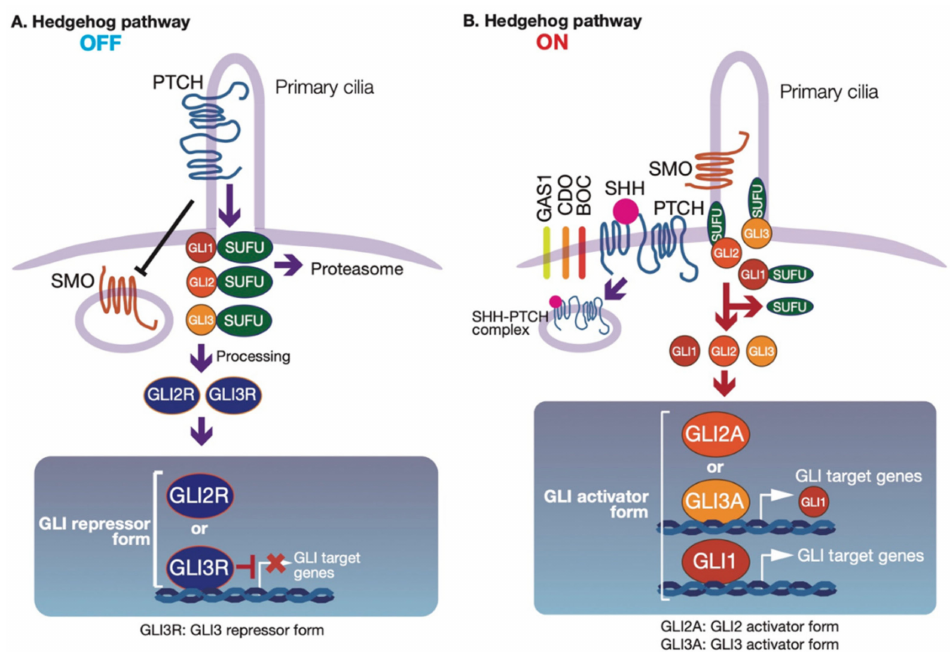
Figure 1. Hedgehog (HH) signaling pathway. ( A ) In the absence of HH ligands (the OFF state), Patched (PTCH) inhibits Smoothened (SMO) from primary cilia, and Suppressor of Fused (SUFU) binds to glioma-associated oncogenes (GLIs) and inhibits their localization to primary cilia and nuclei. SUFU binding of GLI1 and GLI2 is degraded, leading to the GLI2 or GLI3 repressor forms, followed